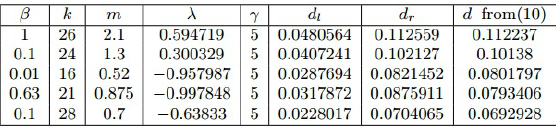
B OUNDS FOR d COMPUTED BY EQUATION (9) FOR VARIOUS β , k , m